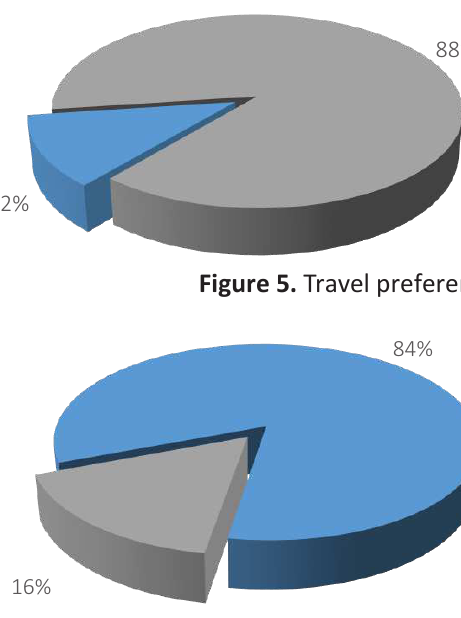
Figure 6. Are you financially